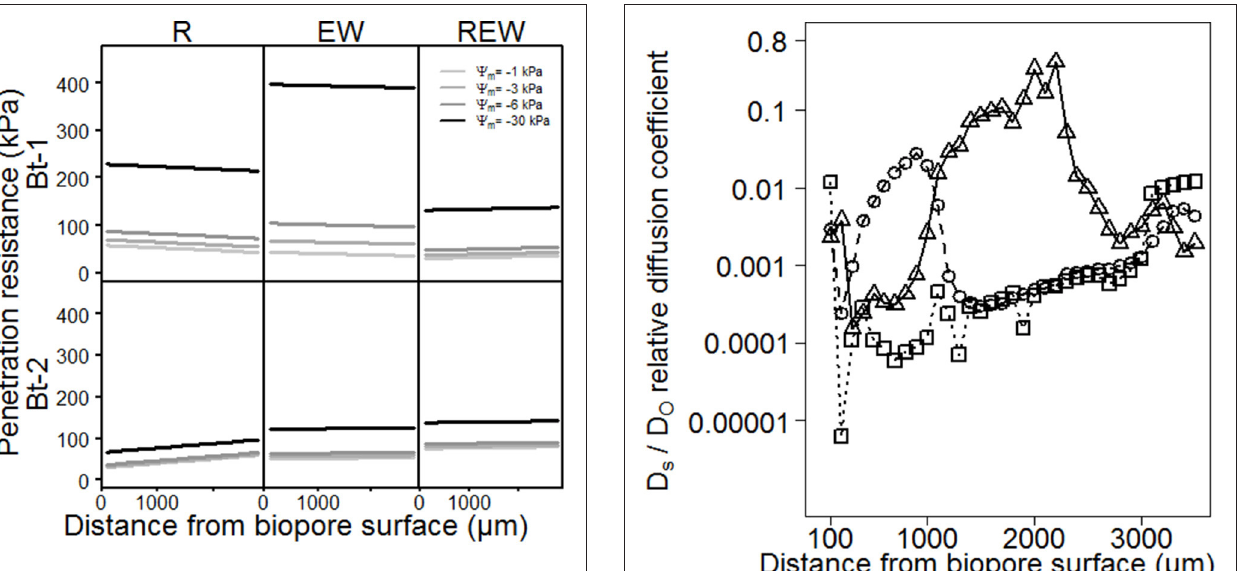
FIGURE 4 | Model output of the statistical analysis of penetration resistance of biopore walls [pore colonized by root (R), colonized by L. terrestris (EW) and (REW) just as R but followed by short-term ( < 6 months) colonization of L. terrestris ] as a function of matric potential.